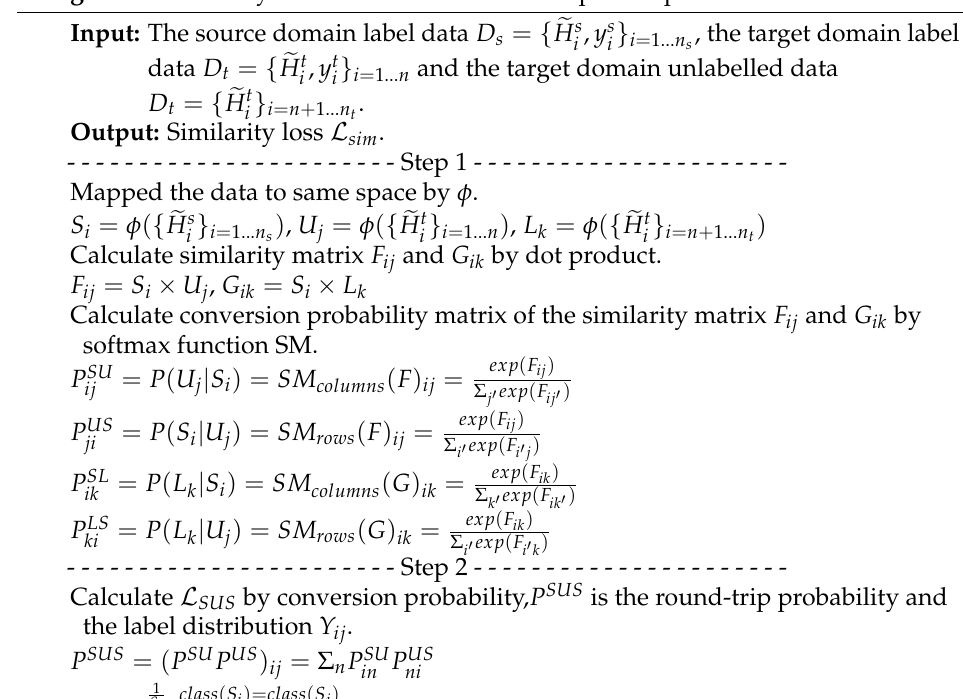
Algorithm 2: The dynamic associate domain adaptation